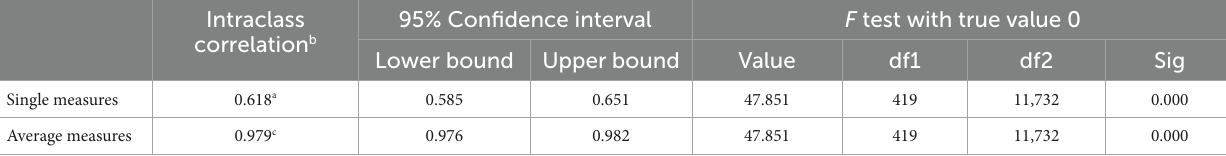
TABLE 9 Intraclass correlation coefficient.